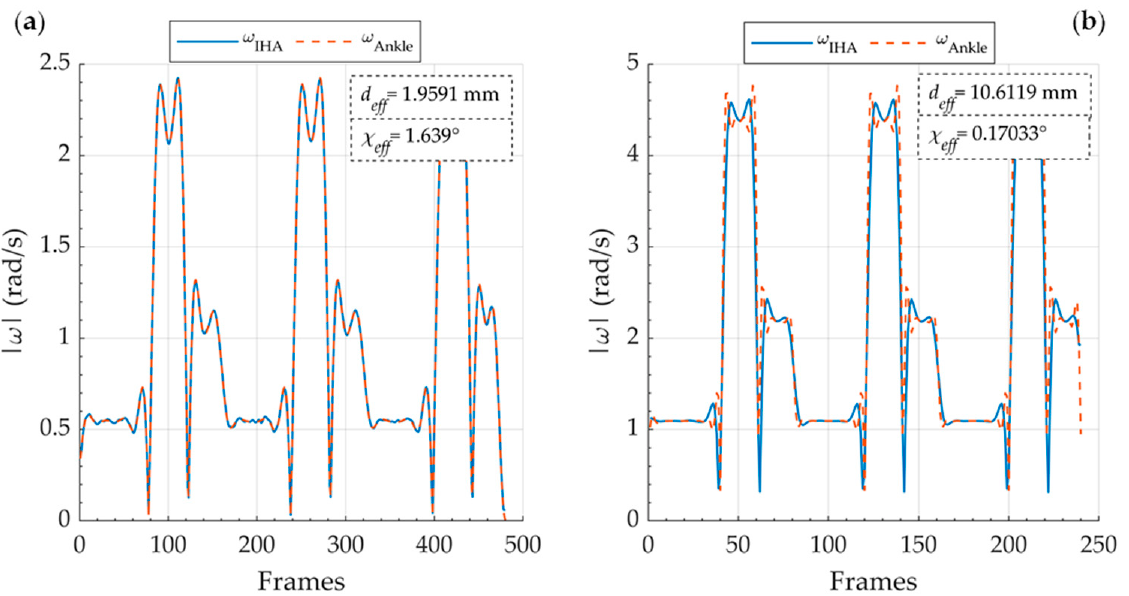
Figure 7. The absolute value of the angular velocity signal, as imposed by the model ( ω Ankle , dashed line) in motion configuration A, and as estimated by the IHA algorithm ( ω IHA ). The two plots were obtained by considering the same sampling frequency ( f S = 100 Hz) and different motion speed: ( a ) lowest speed, V1; ( b ) highest speed, V3. Dispersion parameters are reported in each plot.